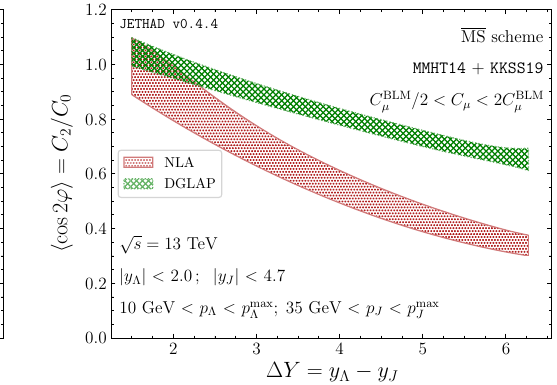
Error bands provide with the combined uncertainty coming from scale variation and numerical integrations. Text boxes inside panels show √ s = 13 TeV. transverse-momentum and rapidity